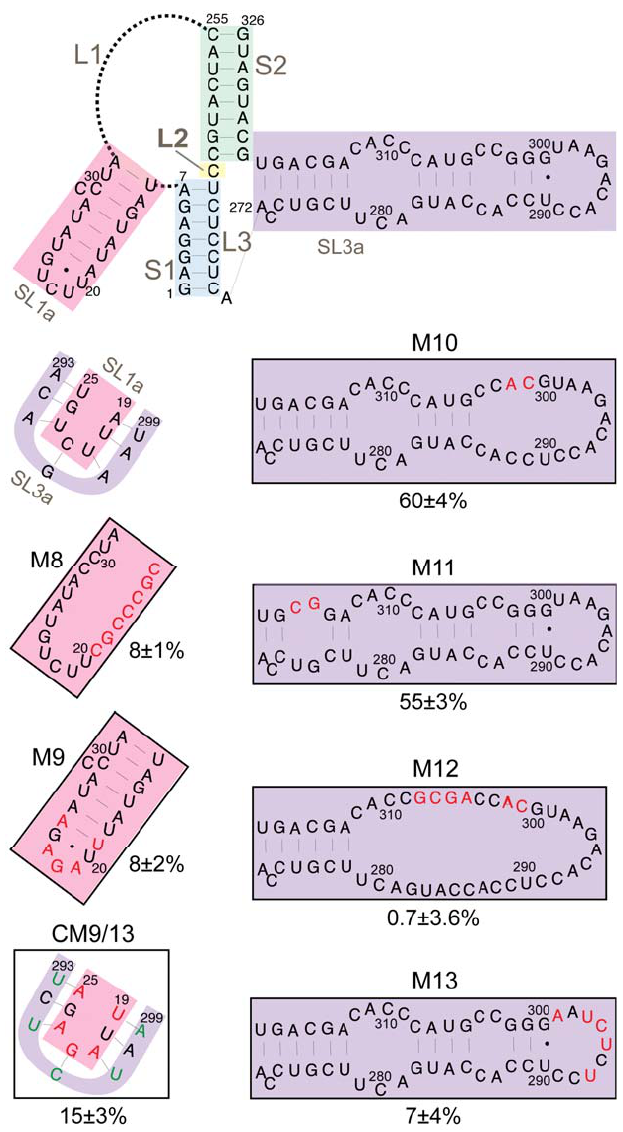
Figure 7. Retrotransposition of mini ‐ Ty1 his3AI elements with mutations in stem ‐ loops SL1a and SL3a. The schematic (top) shows the secondary structure of the Ty1 pseudoknot core and loops L1, L2 and L3, with the SL1a hairpin (pink shading) and SL3a hairpin (purple shading) highlighted. A second schematic (second from top, left) shows the proposed kissing loop interaction between the seven apical nucleotides of hairpin SL1a (pink shading) and seven apical sequences of the SL3a hairpin. Labeled, boxed schematics show the nucleotide substitutions or additions in each mutant mini ‐ Ty1 his3AI element analyzed. Black letters indicate wild ‐ type sequence; red letters indicated nucleotide substitutions or additions; and green letters indicate compensatory substitutions that are predicted to restore base ‐ pairing with nucleotide substitutions. The percentage below each box is the median frequency of helper ‐ mediated retrotransposition of each mini ‐ Ty1 his3AI bearing the indicated mutation divided by the median helper ‐ mediated retrotransposition frequency of the mini ‐ Ty1 his3AI element with wild ‐ type Ty1 ‐ H3 sequence, +/ − the 95% con fi dence interval.